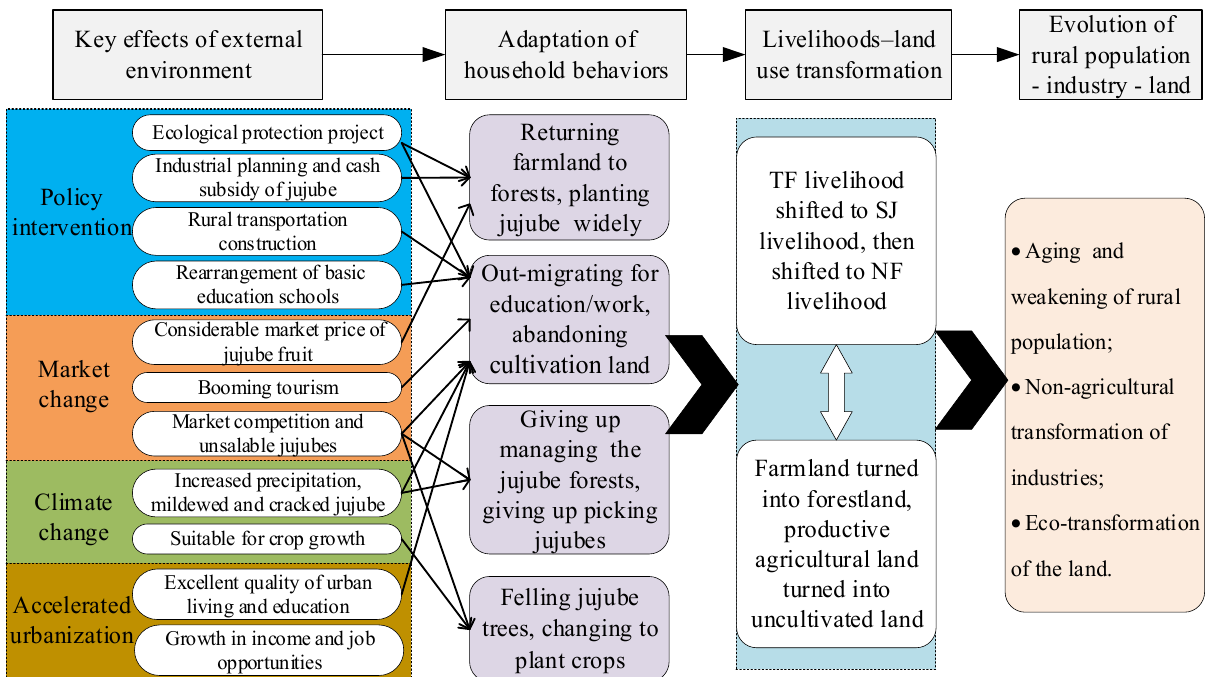
Figure 7. Driving force and path of rural transformation in the Loess Plateau region.